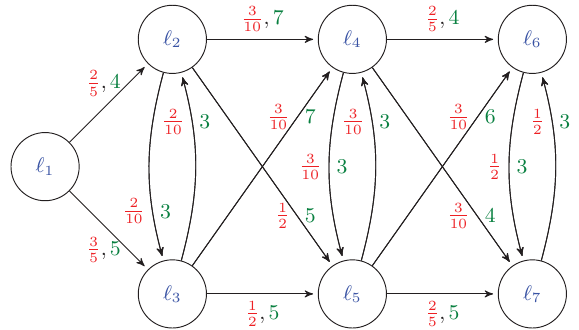
Figure 1: The graph of the population spatial distribution /lo- cations distribution. Note that this is not the graph of the patch- PCTMC model but just the graph of the locations. The nodes (cid:2) 1 , ..., (cid:2) 7 represent the different communities; the edges repre- sent the connection between the communities through the water basin, with the verse of the rows chosen in agreement with the river flow. The red numbers correspond to the probability p i,j to go from (cid:2) i to (cid:2) j and the green numbers correspond to the values w of the distance between